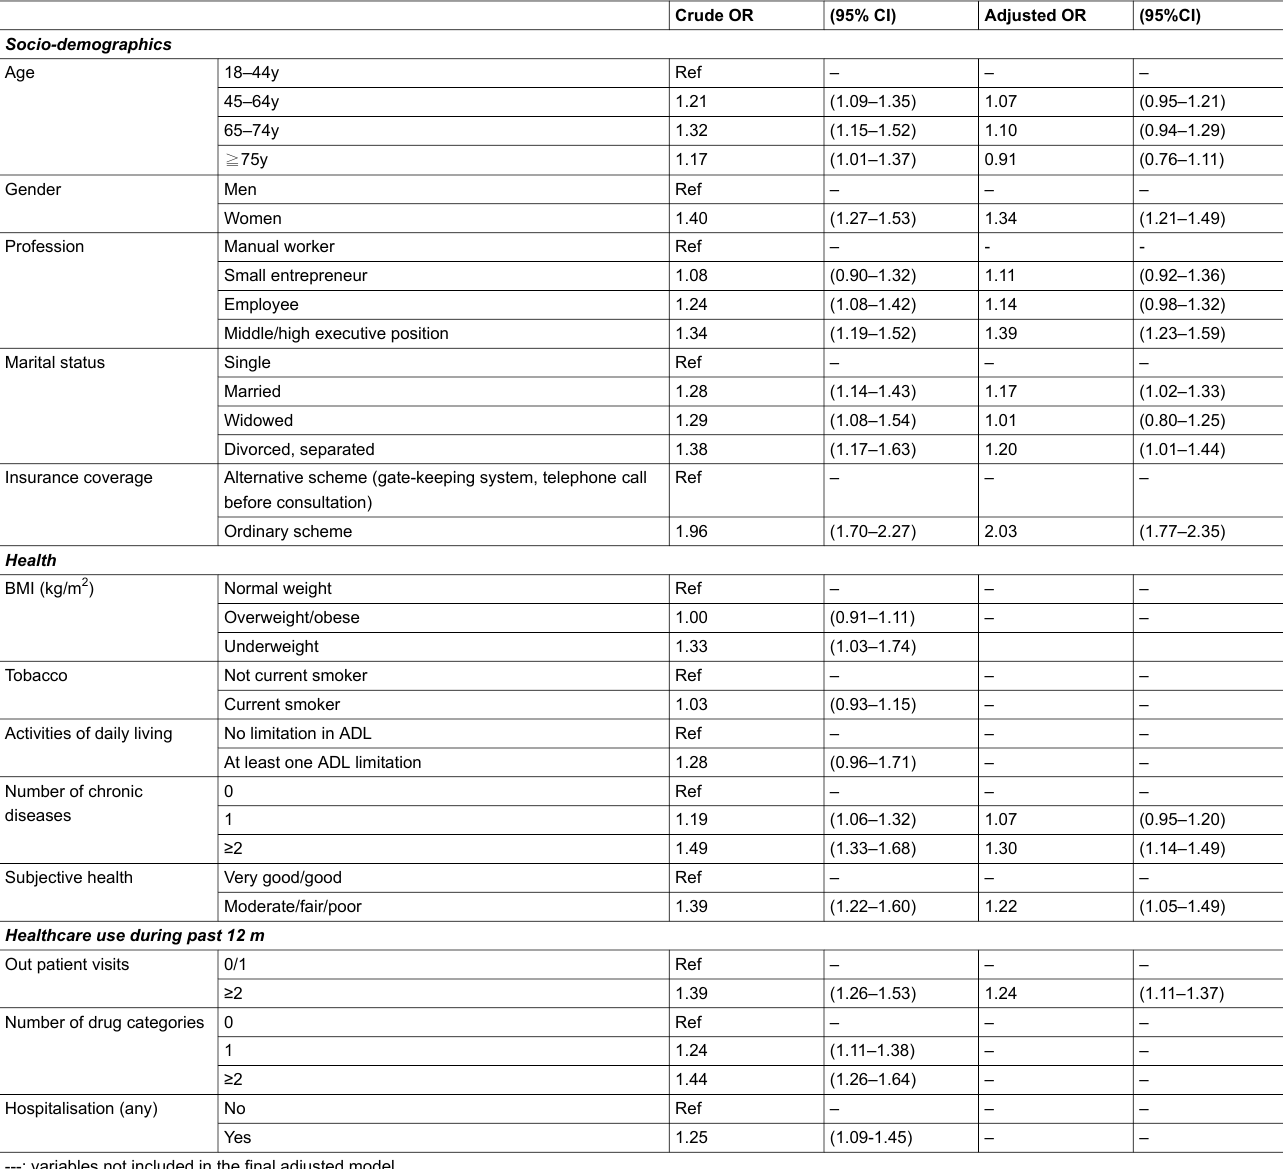
Table 2: Crude and adjusted logistic regressions for the importance of being able to choose specialist